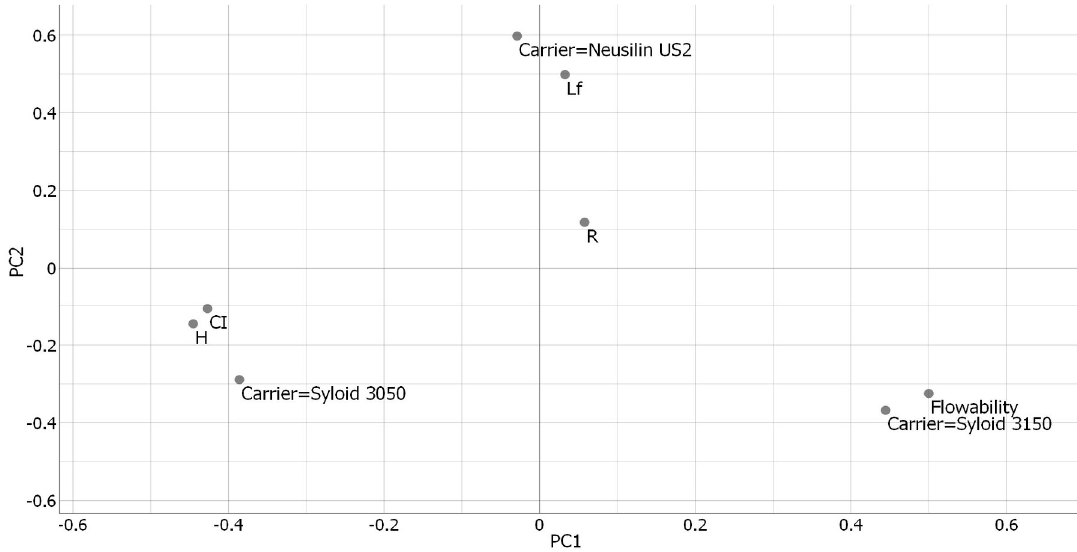
Figure 3. Results of principal component analysis for LS admixtures’ flowability results; PC1—first principal component; PC2—second principal component.